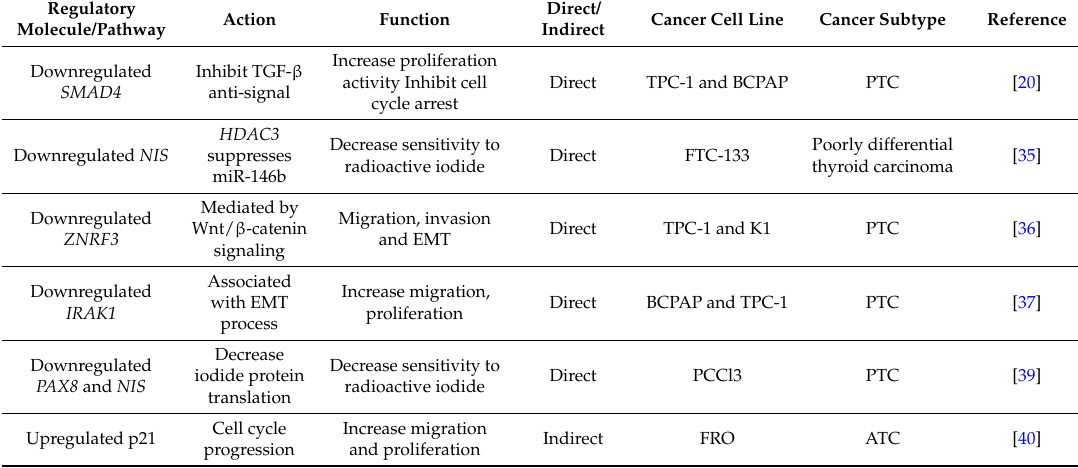
Table 1. Summary of miR-146b regulatory molecules and their effects in thyroid cancer cell